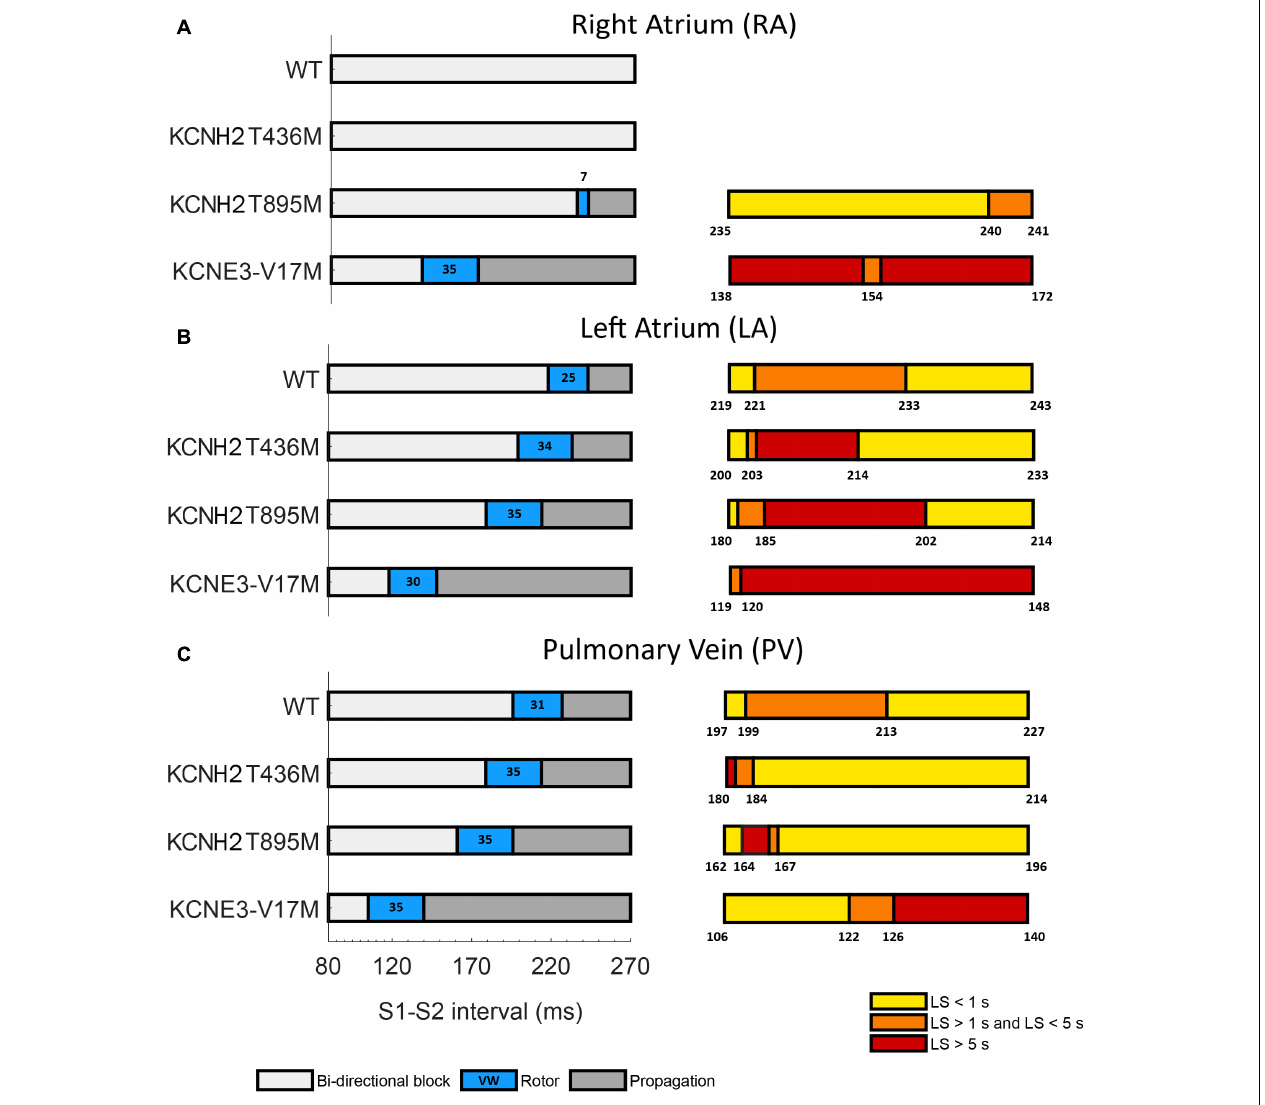
FIGURE 5 | Temporal vulnerability to spiral waves generation of (A) right atrium, (B) left atrium, and (C) pulmonary vein tissues in WT conditions and in the presence of the KCNH2 T436M, KCNH2 T895M, and KCNE3-V17M mutations. Left panels: bi-directional conduction block (white), rotor generation (blue), and propagation (gray). Numbers inside the blue regions (rotor) are the vulnerable window widths in ms. Right panels: classification of the rotors elicited in each VW based on their life-span (LS): smaller than 1 s (yellow), from 1 to 5 s (orange), and longer than 5 s (red). Numbers indicate the